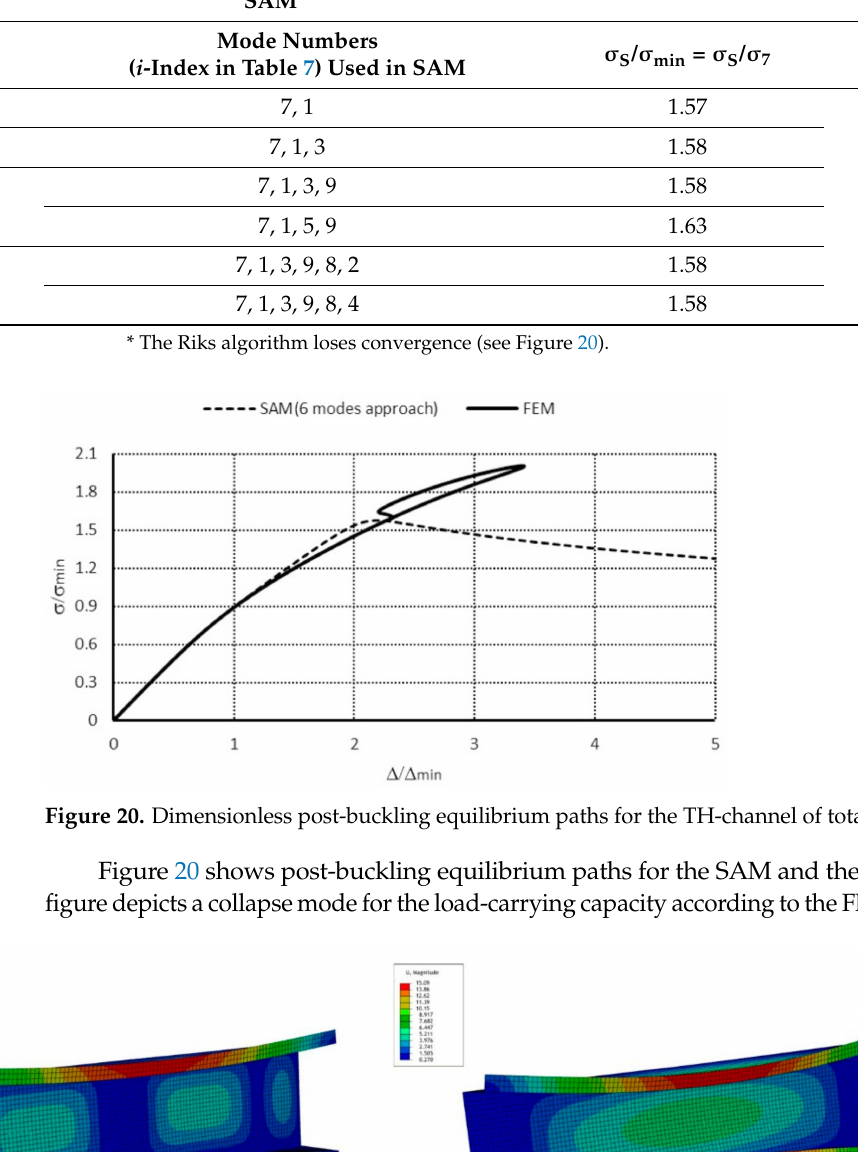
Table 8. Values of the dimensionless ultimate load-carrying capacity for the TH-channel of total length 330 mm. SAM and FEM results. SAM FEM J -Mode Approach